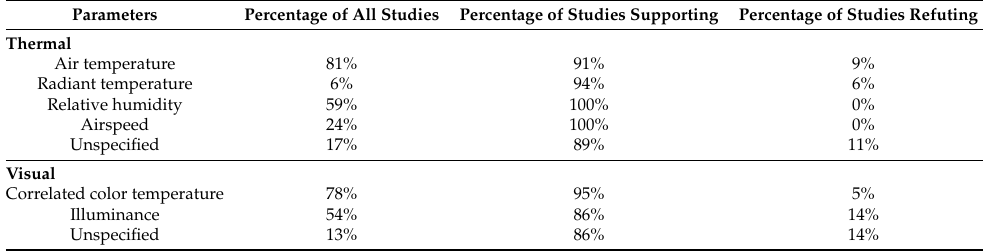
Table 3. Repartition of measured environmental parameters.